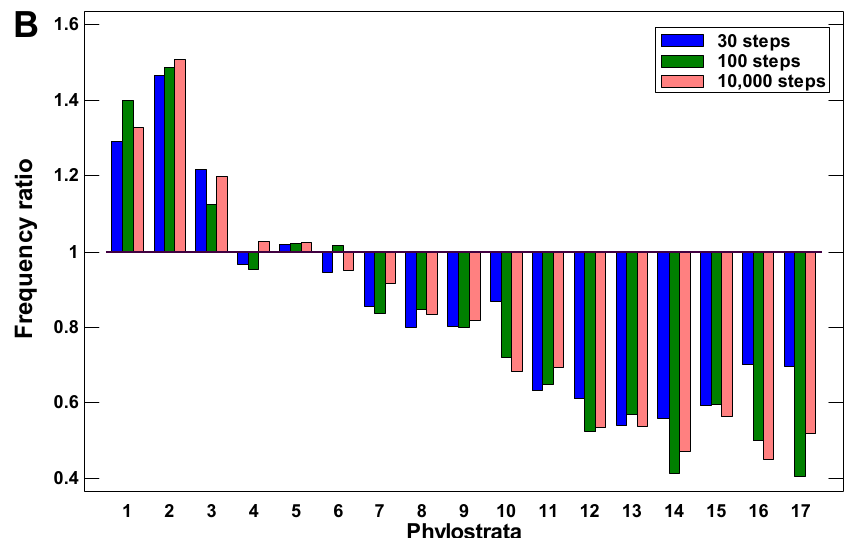
Figure 2. The results of random walks along the protein interaction trajectories in the human interactome: the frequency of walk ends in each phylostratum normalized to gene number in this phylostratum (all walks began in 17th phylostratum): ( A ) walks of 5–20 steps long; ( B ) walks of 30–10,000 steps long. The enrichment of walk ends in the UC center is highly significant (beginning from 10 steps, p < 10 –16 ). Phylostrata: 1—cellular organisms (Prokaryota); 2—Eukaryota;